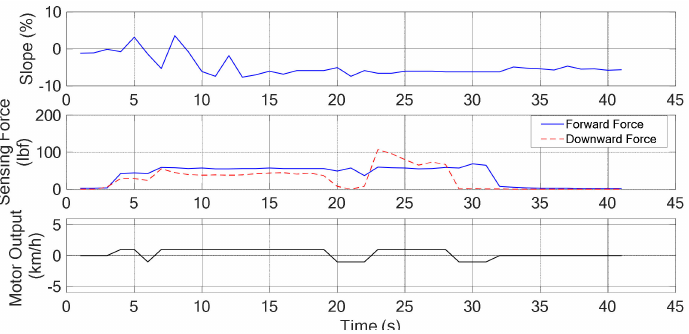
Figure 12. The degree of slope, sensing force, and the assistive motor output (downhill).